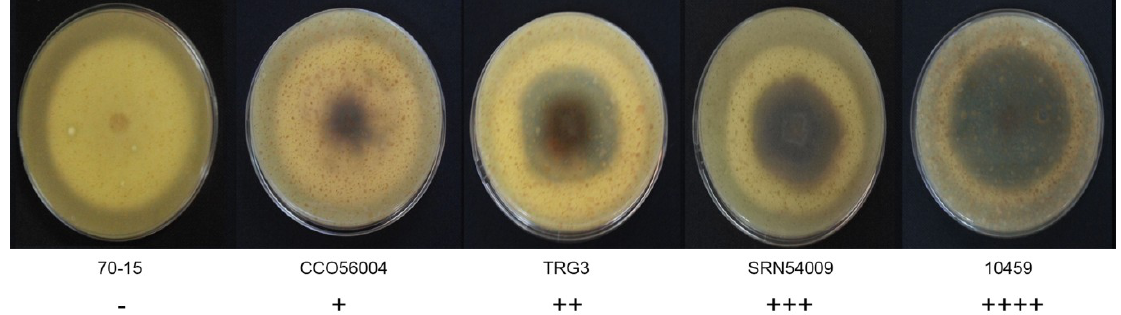
Figure 2. Variation in Pyricularia oryzae melanin production on ventral view of the rice flour agar (RFA) medium, showing differences in melanin production ability. Scoring: No melanin pigment (-), melanin pigment production in less than 20% of the mycelia area (+), melanin production in 20%–50% of the mycelia area (++), melanin production in 50%–80% of the mycelia area (+++), and melanin production in more than 80% of the mycelia area (++++).